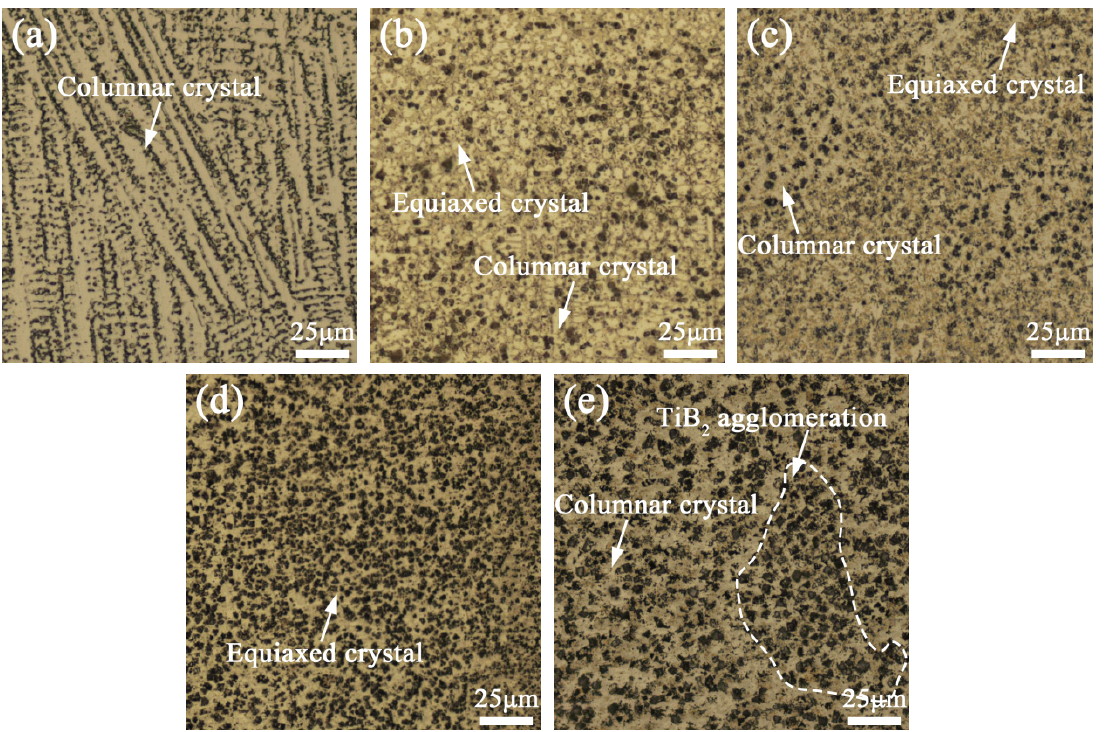
Figure 6. OM (optical microscope) images of the microstructure of coatings ( a ) TB0, ( b ) TB10, ( c ) TB20, ( d ) TB30 and ( e ) TB40.